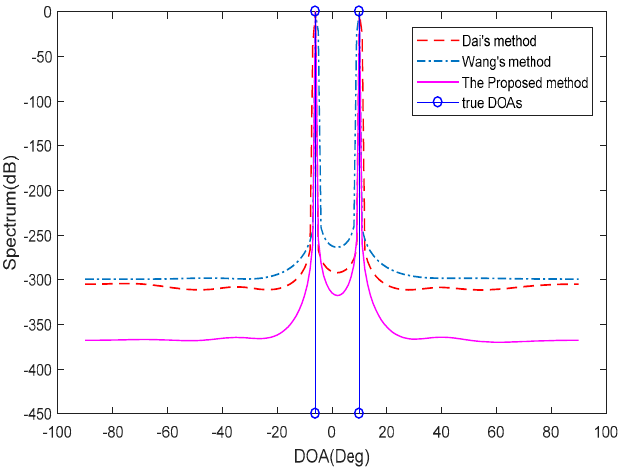
Figure 1. The spatial spectrum of the proposed method, Wang’s method, and Dai’s method.